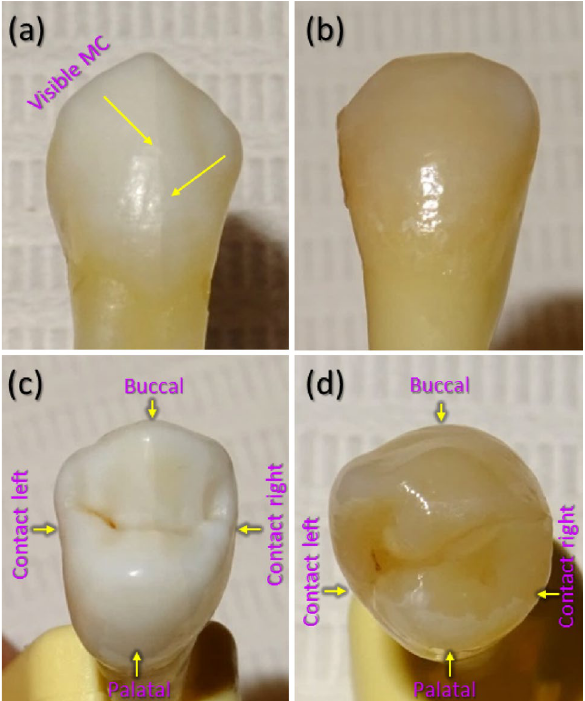
Figure 1. An example of photographs of two teeth with visible ( a , c ) and invisible ( b , d ) enamel microcracks (MCs) on the buccal tooth surface. Visible MCs and tooth surfaces are marked. Panels ( a , b ) show buccal view, while panels ( c , d )—occusal